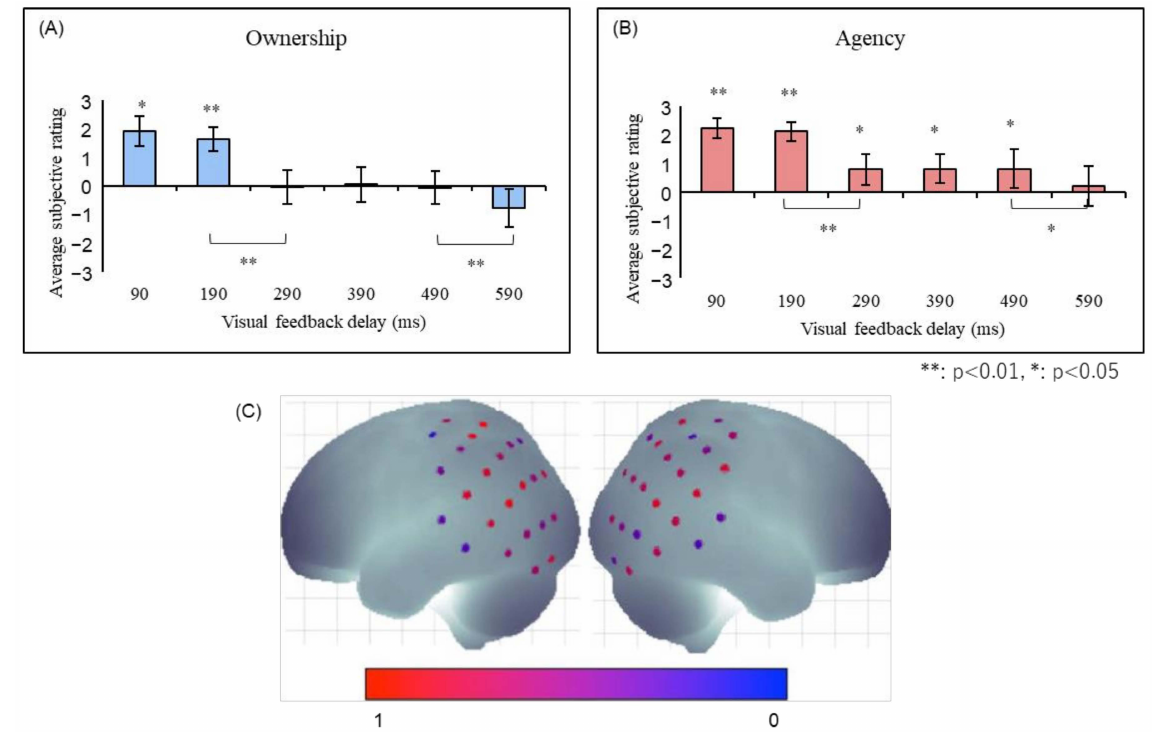
Figure 4. ( A ) The sense of ownership and ( B ) agency in robot hand illusion [41]. Both senses showed significant reductions in the 290-ms and 590-ms conditions, with the major difference being that the sense of agency was significantly felt in the 290–490-ms conditions, while the sense of ownership was not. ( C ) The right angular gyrus was significantly activated when the robot hand illusion was felt in the 100 ms condition compared to the 400 and 700 ms conditions